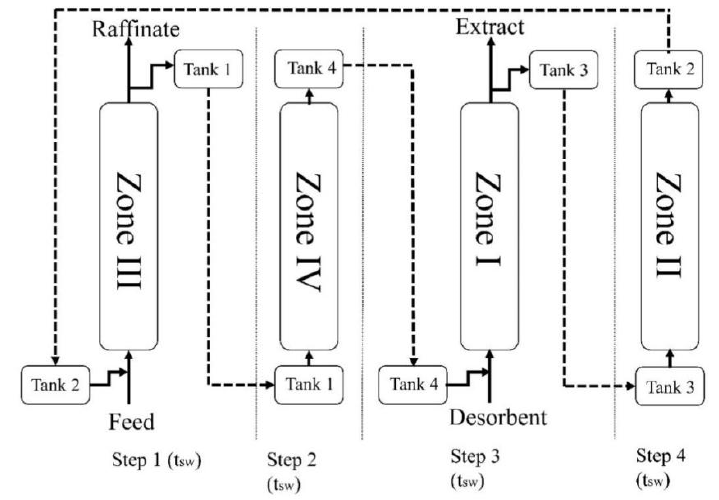
Figure 4. Schematic diagram of one-column SMB.